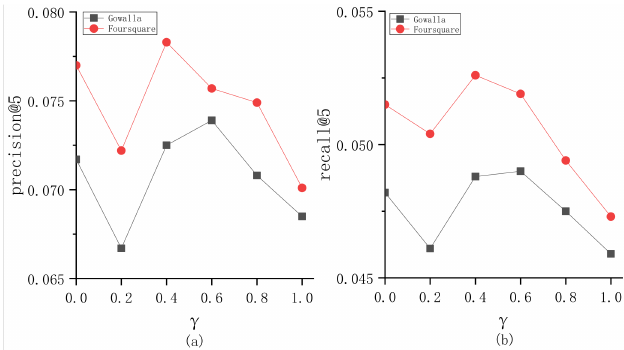
Figure 8. The sensitivity analysis of γ . ( a ) precision @5; ( b ) recall @5.